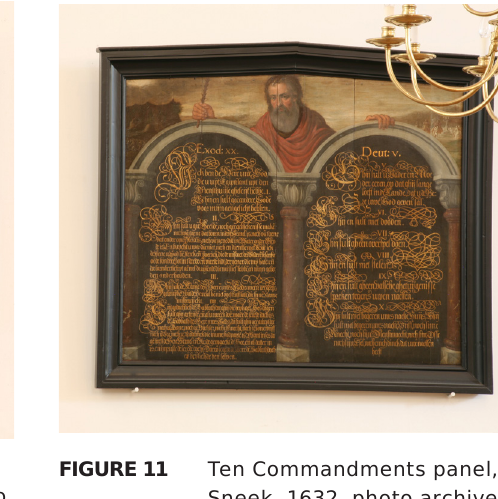
Ten Commandments panel, Sneek, 1632, photo archive Regnerus Steensma.